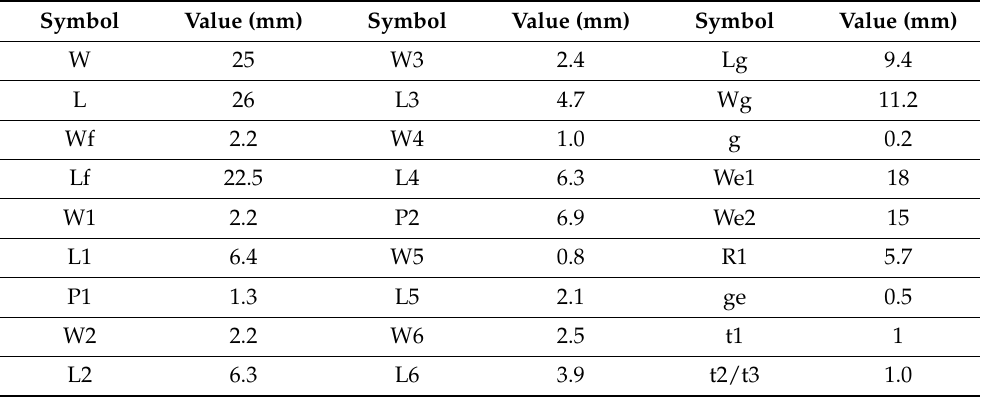
Table 1. The dimensions of the monopole antenna and EBG